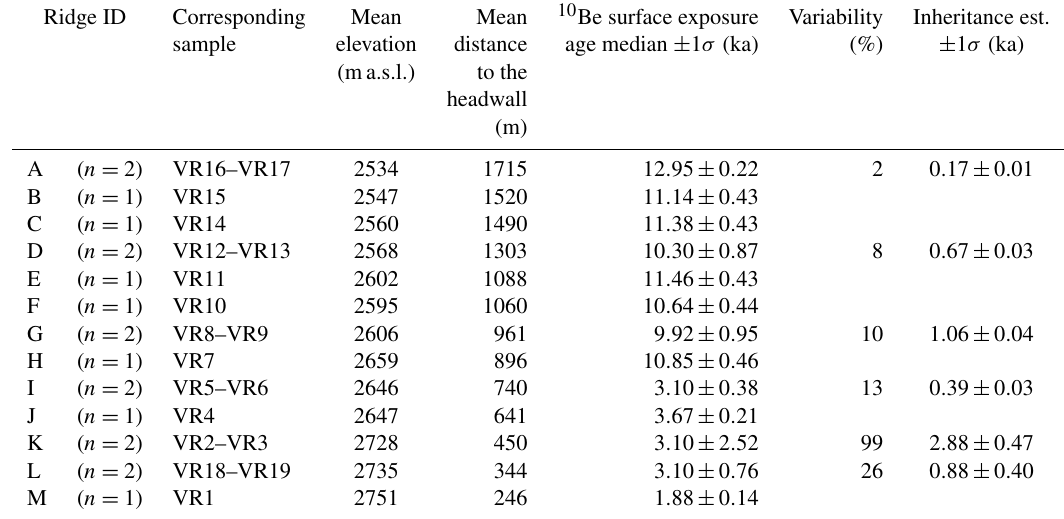
Table 3. The 10 Be surface-exposure ages for each ridge of the rock glacier system of the Vallon de la Route (Combeynot Massif, France), where n represents the number of samples per ridge. For the ridges with replicates, the median values are reported with the standard variation ± 1 σ . For the inheritance estimate, the difference in 10 Be concentration of each pair of replicates has been used, and 10 Be surface-exposure ages have been recalculated assuming an origin in the headwall (at an elevation of 2997ma.s.l.). Ridge ID Corresponding Mean Mean 10 Be surface exposure Variability Inheritance est. sample elevation distance age median ± 1 σ (ka) (%) ± 1 σ (ka) (ma.s.l.) to the headwall